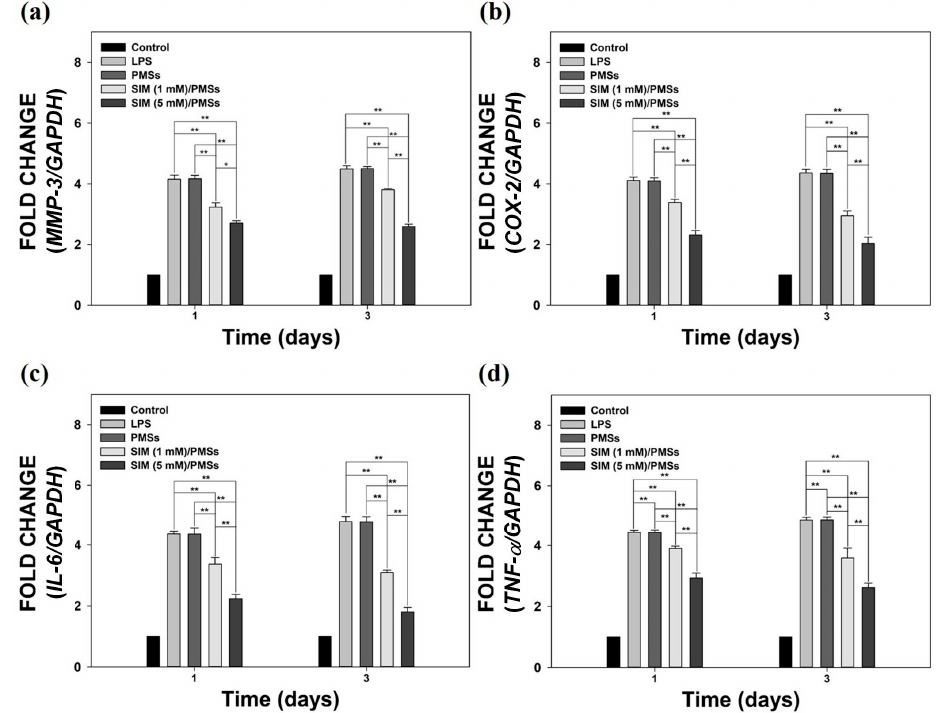
Figure 3. The relative mRNA expression levels of pro-inflammatory cytokines, including: ( a ) MMP-3 , ( b ) COX-2 , ( c ) IL-6 , and ( d ) TNF- α in lipopolysaccharide (LPS)-stimulated tenocytes that were cultured with PMSs, SIM (1 mM)/PMSs, and SIM (5 mM)/PMSs on days 1 and 3. Error bars represent the means ± SDs ( n = 5). (* p < 0.05 and ** p <0.01).